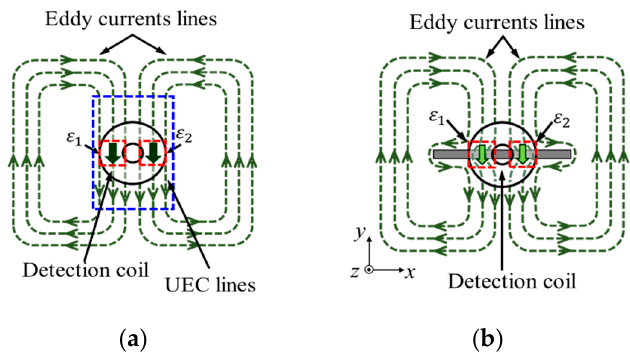
Figure 2. Butterfly probe under balanced conditions: ( a ) without flaw, ( b ) with flaw.